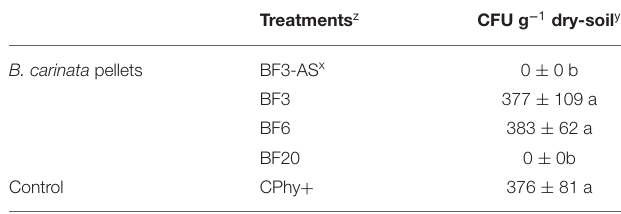
biofumigation process in the laboratory